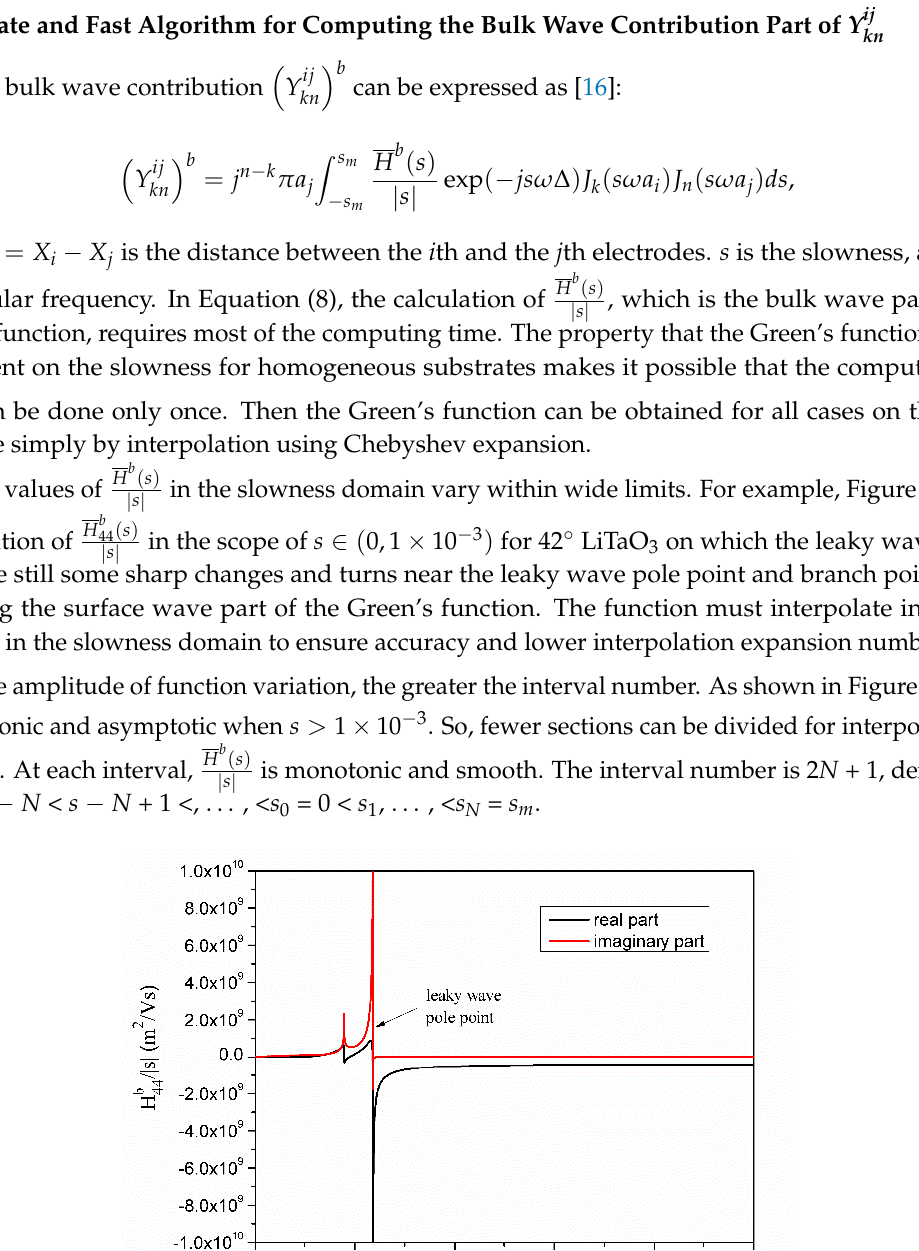
Figure 3. Plot of function H